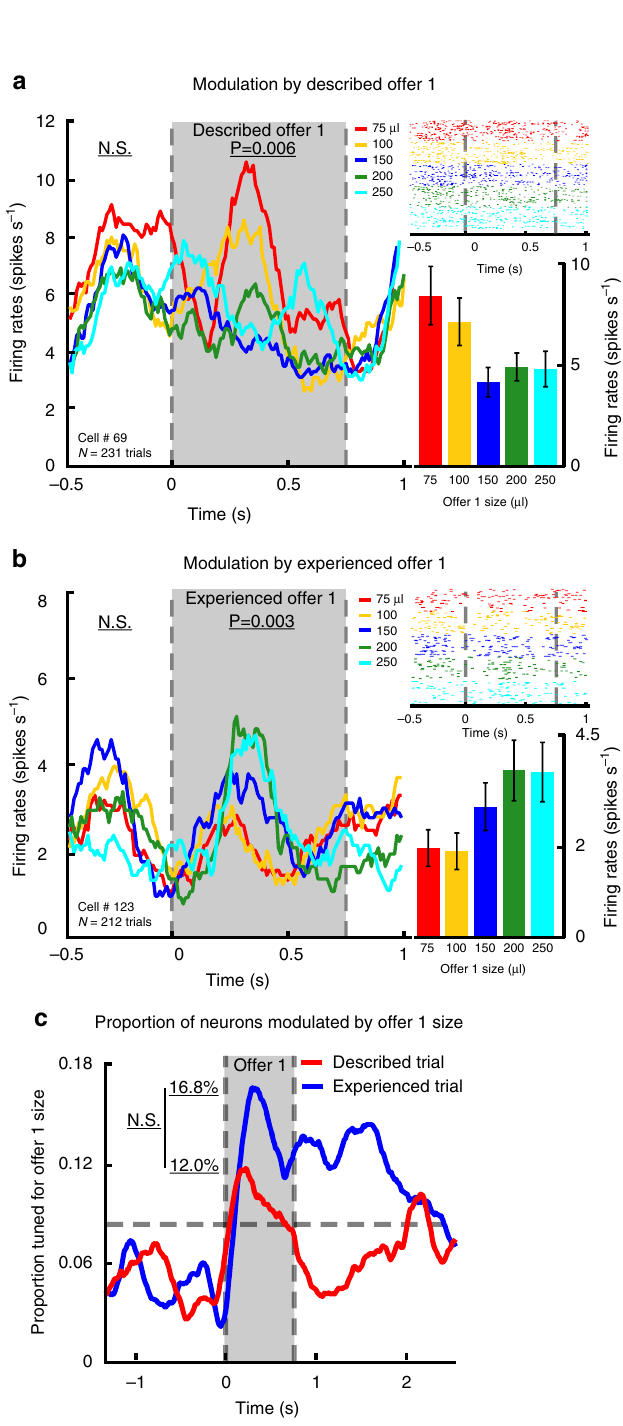
Figure 3 | Neural encoding of offer. ( a ) Left: Peristimulus time histogram (PSTH) for one example neuron that showed reduced firing rates in response to larger described offer. Top right: raster plot of the same example neuron; trials are sorted by offer 1 size. Bottom right: bar graph of the same example neuron showing averaged firing rates for each offer 1 size. ( b ) Another example neuron that showed enhanced firing rates in response to larger experienced offer. ( c ) Proportion of neurons in our data set that were selective for the size of described (red) and experienced (blue) offers; sliding-window regression analysis. Chance level is based on binomial test and is indicated by grey dashed